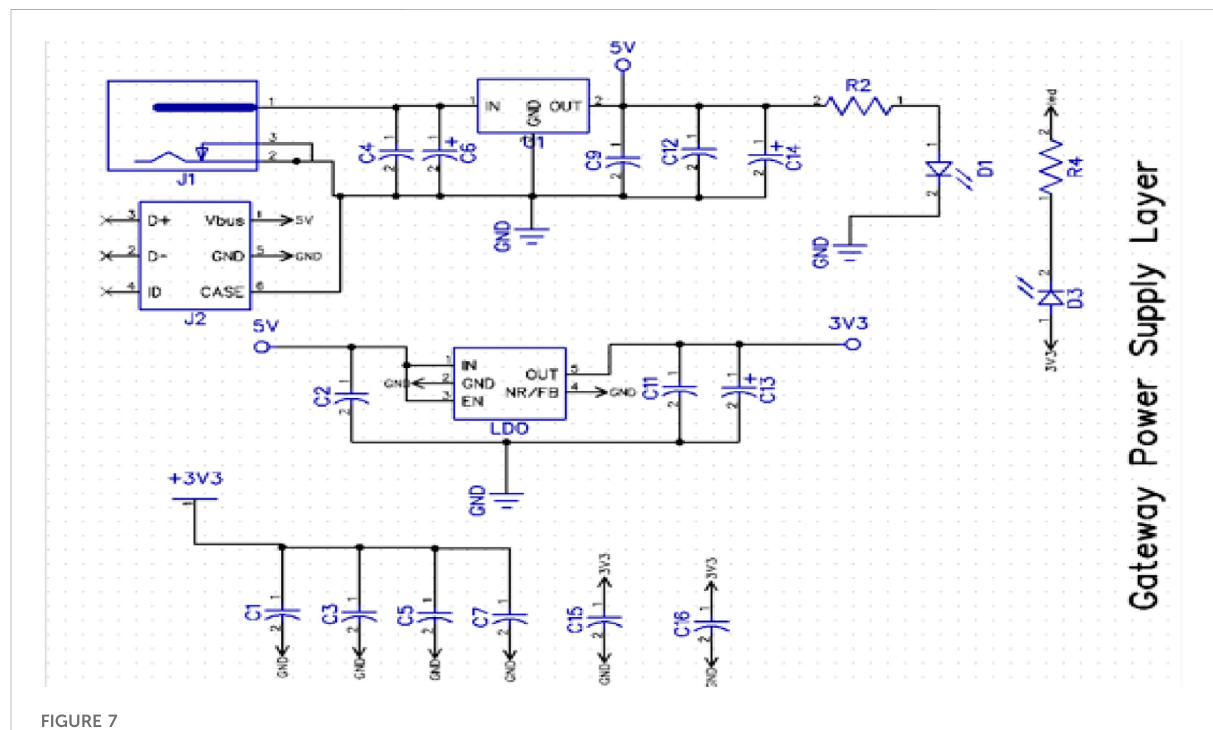
FIGURE 7 Schematic diagram of the gateway ’ s power supply